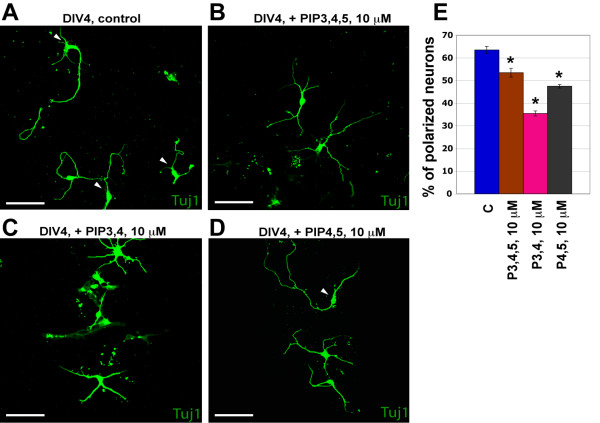
Analysis of phosphatidylinositol (PIP) involvement in the polarization of SVZ/RMS-derived neurons. Cultured cells were treated with different PIPs, and polarization of Tuj1-positive cells was determined at DIV4. (A) - (D) Examples of vehicle (A), PIP3,4,5 (B), PIP3,4 (C) and PIP4,5 (D) -treated SVZ/RMS cultures are shown. Arrowheads mark polarized neurons. (E) Treatment with PIPs significantly decreased number of polarized neurons in SVZ/RMS culture (* - p < 0.01). Abbreviations: Tuj1 - tubulin beta III to label immature neurons. Scale bars are 50 μm.